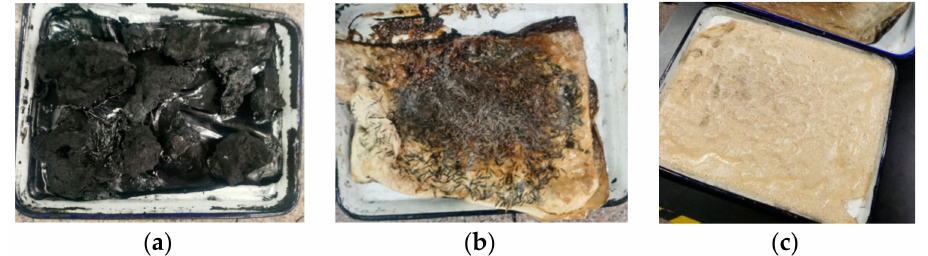
Figure 5. Fiber-reinforced natural latex masterbatches: ( a ) Flocculation of carbon black latex; ( b ) KH560 without latex; ( c ) KH560 with